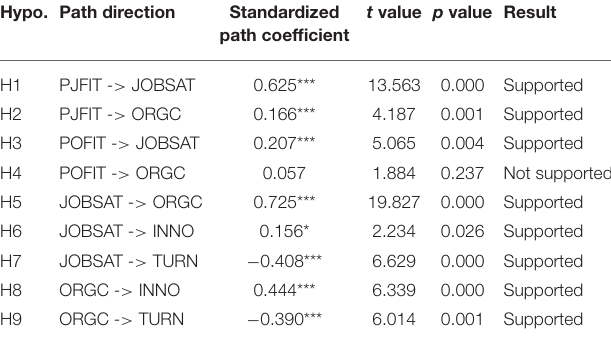
TABLE 5 | Summary of inner model results. Hypo. Path direction